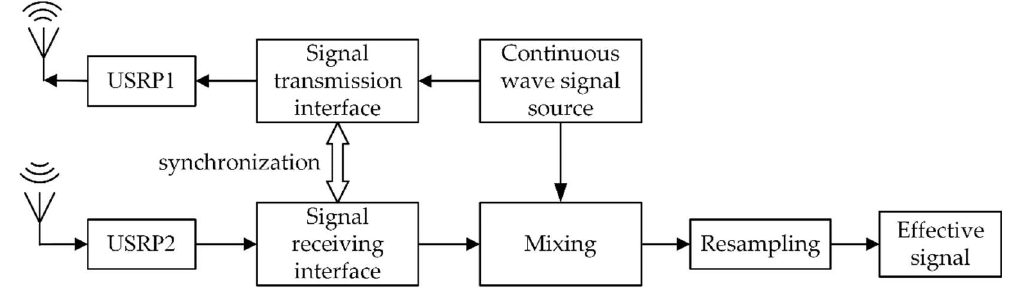
Figure 2. Main components of the continuous-wave radio transceiver.